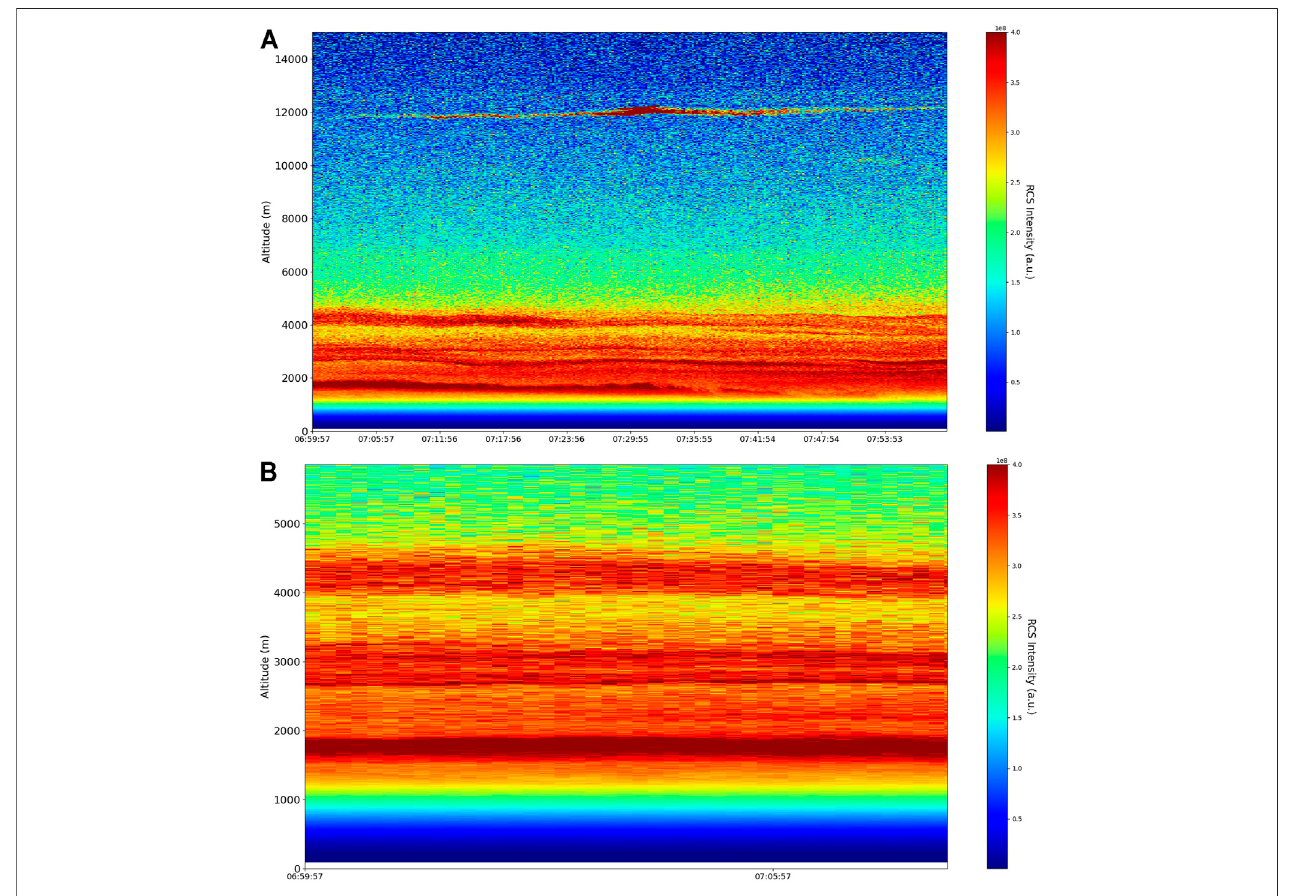
FIGURE 11 | (A) RCS timeseries, Bucharest, Romania, 13/06/2019, (B) zoomed RCS timeseries, Bucharest, Romania, 13/06/2019; area of interest for subsequent laminar channel study.